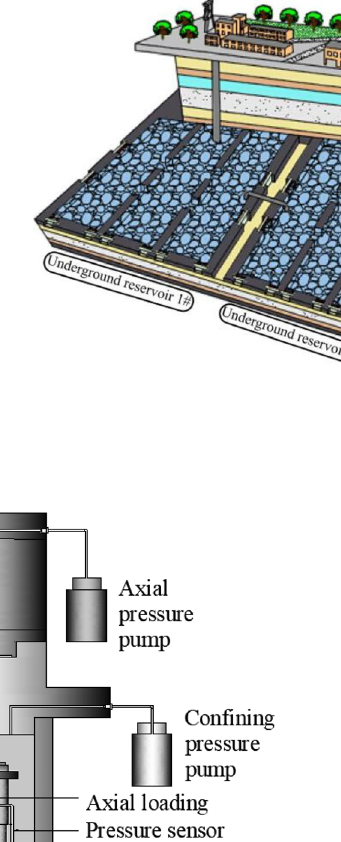
Fig. 1 Schematic diagram